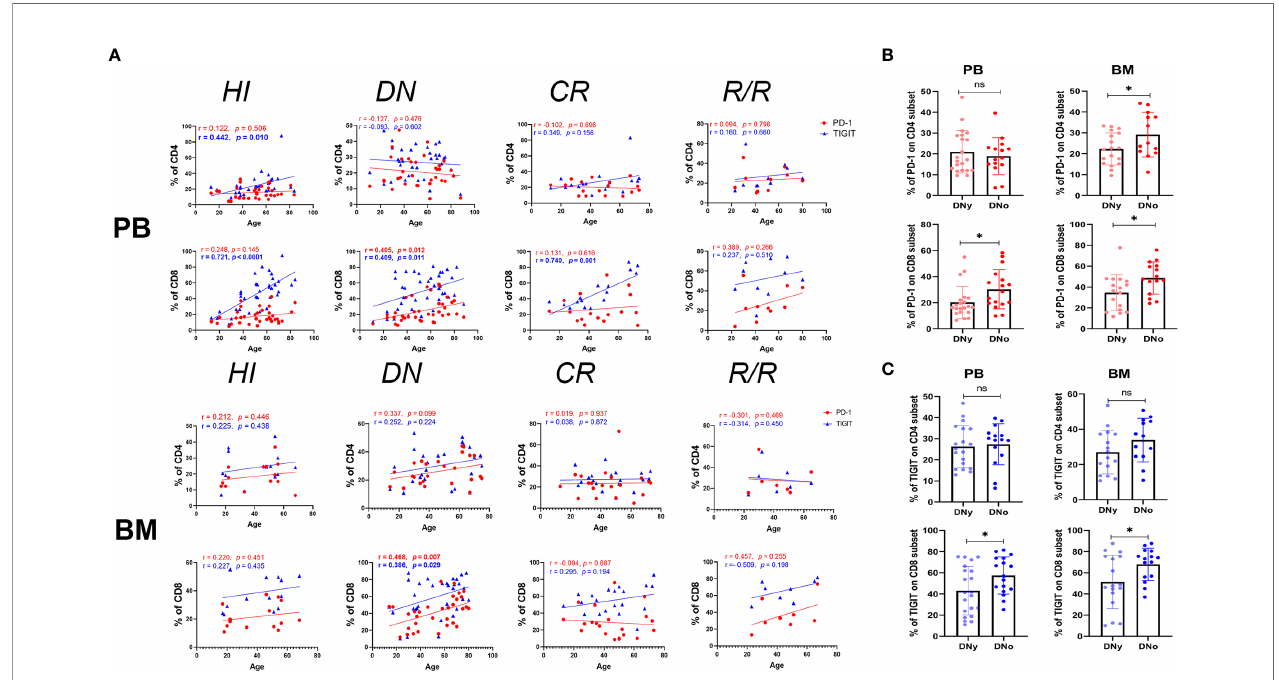
FIGURE 2 | PD-1 + and TIGIT + CD8 + T cells increase in the BM of older DN-AML patients. (A) The upper panel shows the correlation between the frequency of PD- 1 (red dots) or TIGIT (blue triangles) and age in the PB CD4 + and CD8 + T cell populations in HIs (CD4, n=33; CD8, n=36) and patients in the AML-DN (CD4, n=34; CD8, n=38), AML-CR (n=17), and AML-R/R (n=10) cohorts; the lower panel shows the correlation between the frequency of PD-1 (the red dots) or TIGIT (blue triangles) and age in the BM CD4 + and CD8 + T cell populations in HIs (n=14) and patients in the AML-DN (CD4, n=29; CD8, n=32), AML-CR (n=21), and AML-R/R (CD4, n=7; CD8, n=8) cohorts. Spearman ’ s nonparametric test used to test for correlations between each group. (B) Comparison of the expression of PD-1 on CD4 + and CD8 + T cells from the PB of DNy (CD4, n=19; CD8, n=21) and DNo (CD4, n=15; CD8, n=17) (younger and older than 60 years) patients (Left) from the BM of DNy (CD4, n=16; CD8, n=17) and DNo (CD4, n=13; CD8, n=15) patients (Right). (C) Comparison of the expression of TIGIT on CD4 + and CD8 + T cell subsets from the PB and BM of DNy and DNo AML patients. The sample cases used for TIGIT are the same as those used for the PD-1 comparison. The p values shown in B and C are from the independent student ’ s t-test. * p < 0.05, ns denotes not signi fi